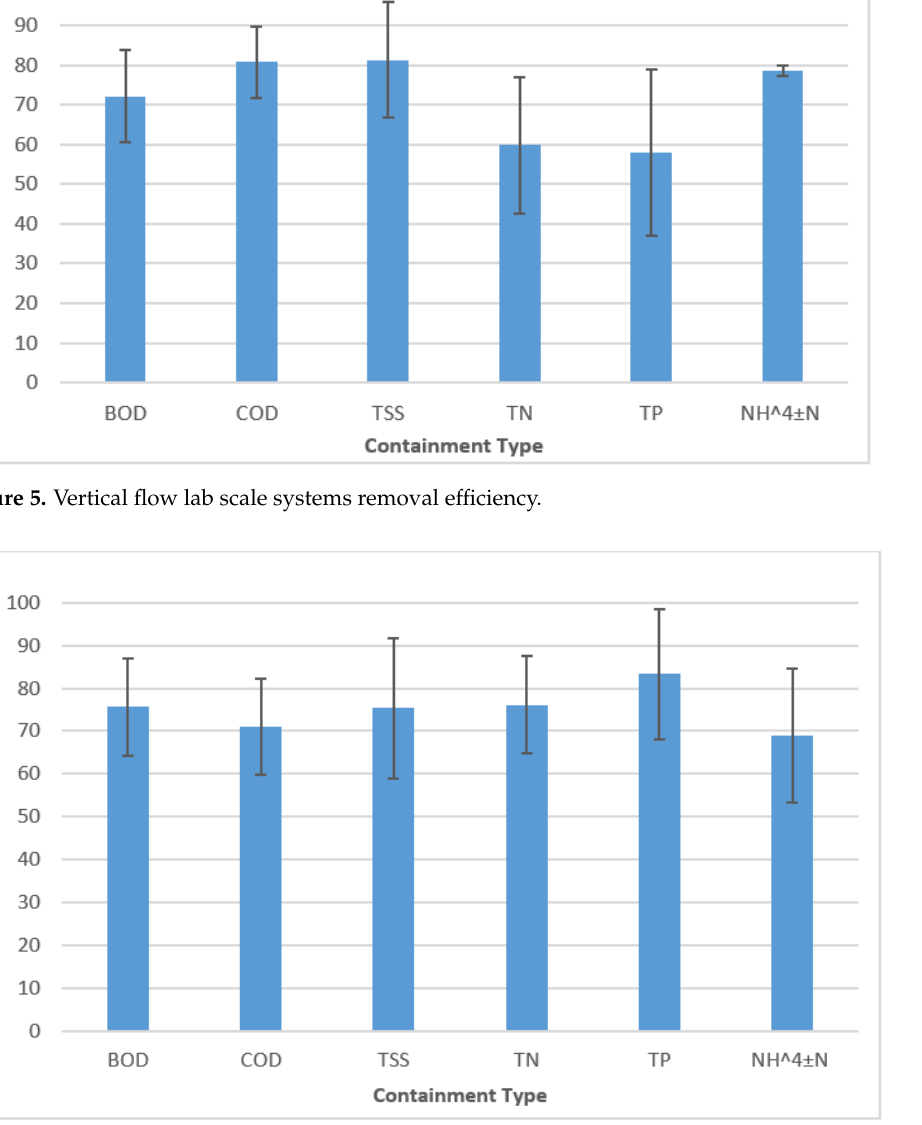
Figure 6. Vertical flow site scale systems removal efficiency.